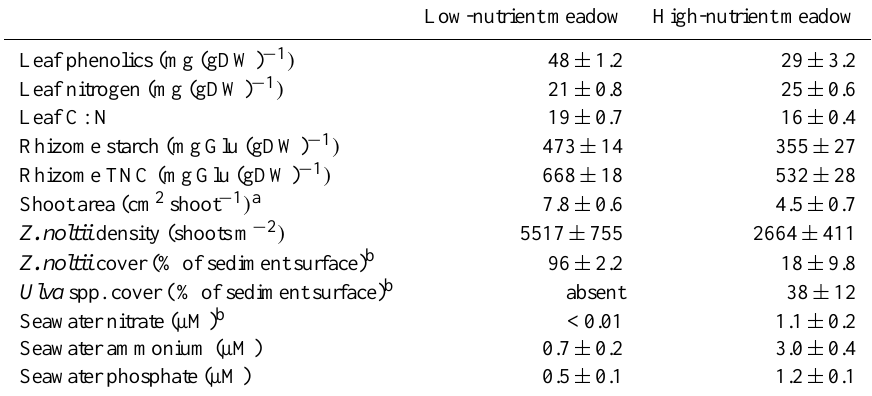
Table 1. Environmental and Zostera noltii community traits (mean ± SE) that revealed significant differences between the low- and high- nutrient donor meadows during June–August 2011, prior to the start of the experiment, tested using unpaired t tests. a Sqrt-transformed data to meet normality. b Mann-Whitney rank tests were conducted for variables that did not meet normality even after transformation. All measured traits and methods are shown in Table S1 in the